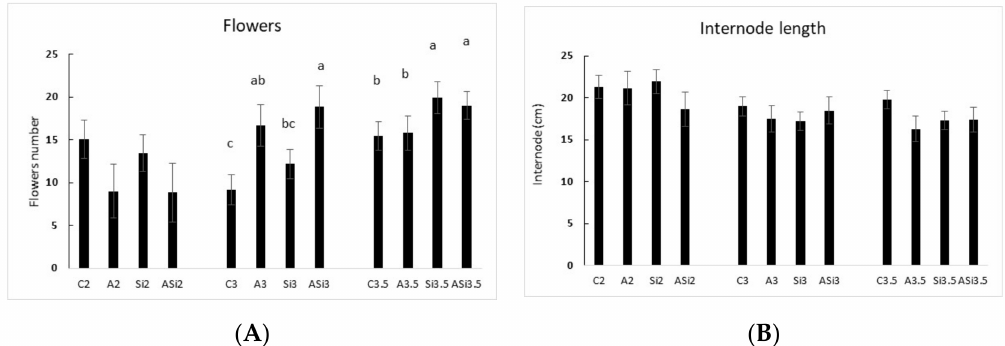
Figure 9. Flower number ( A ) and internode length ( B ) at the end of the trial for the C2 (foliar application with water and fertigation EC 2.0 dS m − 1 ), A2 (foliar application with Arthrospira platensis and fertigation EC 2.0 dS m − 1 ), Si2 (foliar application with Si and fertigation EC 2.0 dS m − 1 ), ASi2 (foliar application with Arthrospira platensis and Si, and fertigation EC 2.0 dS m − 1 ), C3.0 (foliar application with water and fertigation EC 3.0 dS m − 1 ), A3.0 (foliar application with Arthrospira platensis and fertigation EC 3.0 dS m − 1 ), Si3 (foliar application with Si and fertigation EC 3.0 dS m − 1 ), ASi3 (foliar application with Si and Arthrospira platensis, and fertigation EC 3.0 dS m − 1 ) treatments; C3.5 (foliar application with water and fertigation EC 3.5 dS m − 1 ), A3.5 (foliar application with Arthrospira platensis and fertigation EC 3.5 dS m − 1 ), Si3.5 (foliar application with Si and fertigation EC 3.5 dS m − 1 ), and ASi3.5 (foliar application with Si and Arthrospira platensis, and fertigation EC 3.5 dS m − 1 ) treatments. Di ff erent letters indicate significant di ff erences between treatments at the p < 0.05 level using the LSD test. Values are the means of 12 plants. Error bars show standard